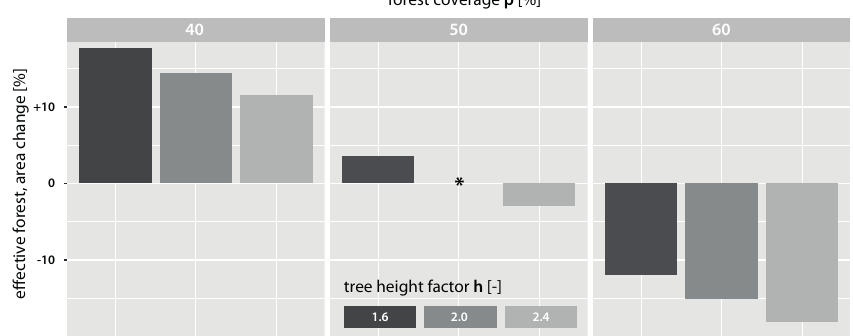
Figure 6. Sensitivity of the delineated area of effective forest on the parameters forest coverage and tree height factor. Area change is expressed as the percent change in relation to the BASE parametrization of effective forests, h = 2 and p = 50% (*).